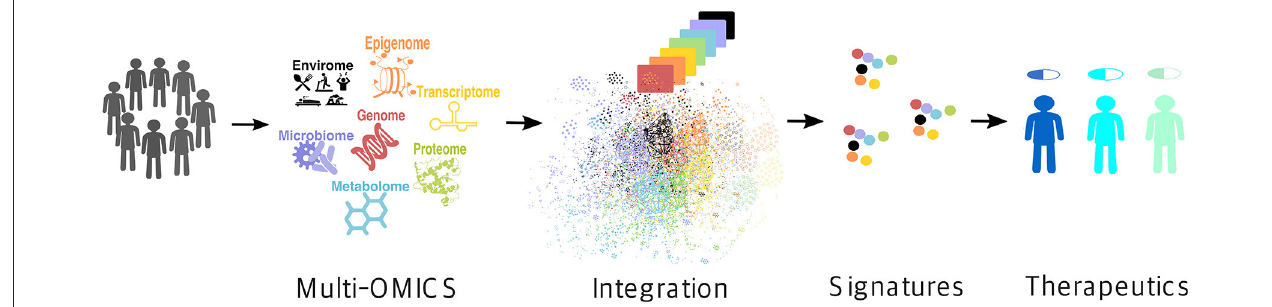
FIGURE 1 | Multi-omics approach for precision medicine. Multi-omics (i.e., genome, epigenome, transcriptome, proteome, metabolome, microbiome, and envirome) data are collected from patients and integrated to create their individual molecular signatures (i.e., complex biomarkers), which are then used to select an appropriate drug for a particular patient, thus improving the treatment efficiency and reducing the possible side effects.